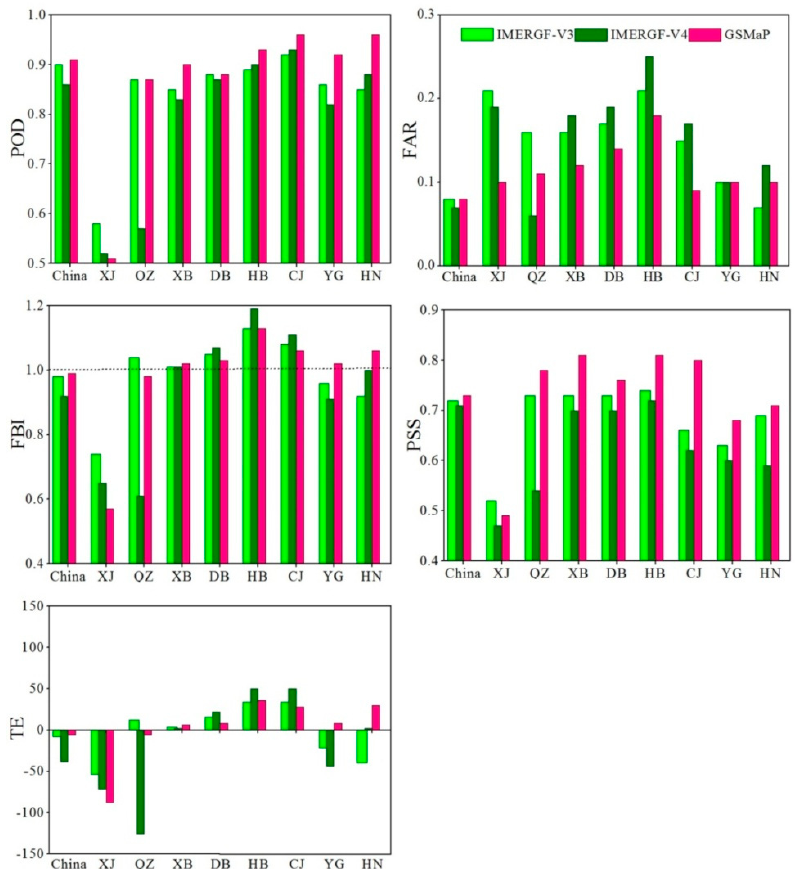
Figure 9. Contingency statistics of daily rainfall for the IMERGF-V3, IMERGF-V4, and GSMaP products compared to CPAP over mainland China and eight sub-regions for 2014. Daily rainfall volumes below 0.5 mm are considered no-rain events.